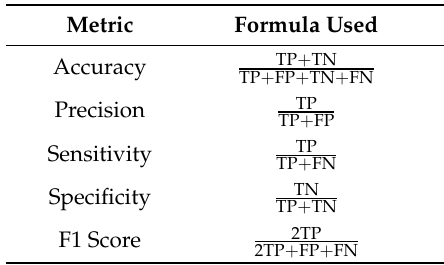
Table 7. Model evaluation